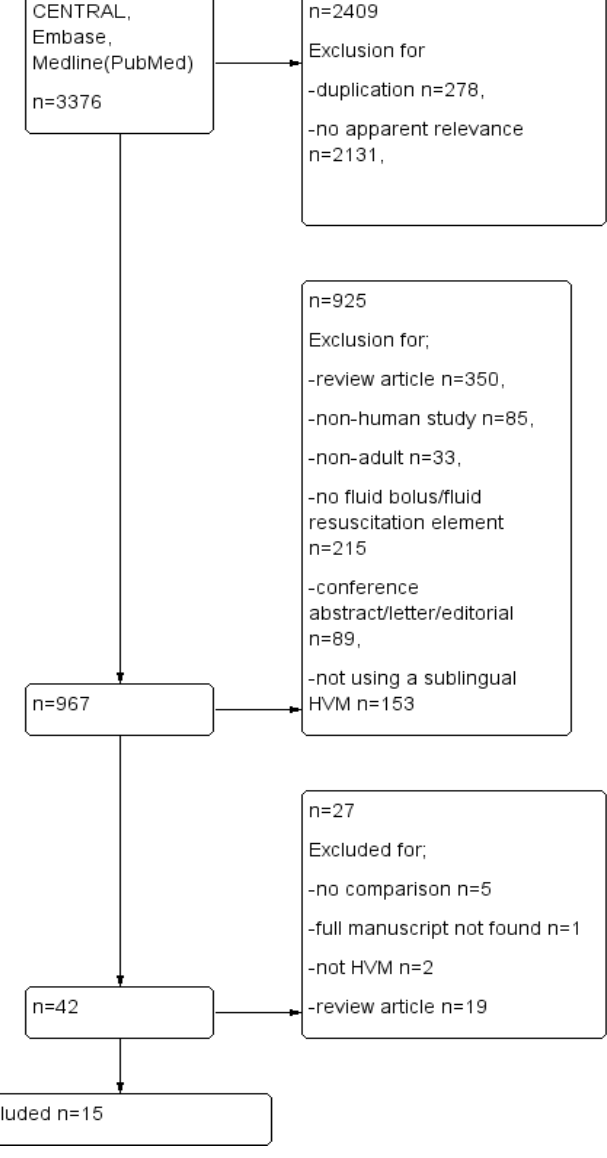
Figure 1. PRISMA flow diagram.